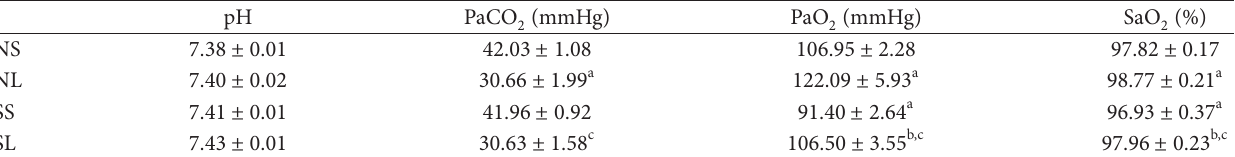
(d) F 5: Hematoxylin and eosin-stained sections of right upper lobe from different groups of rats taken aer 3 hours of LPS administration (HPF, 400x). (a) Normal rats injected with saline; (b) STZ-induced diabetic rats injected with saline; (c) normal rats injected with LPS; (d) STZ-induced diabetic rats injected with LPS. Arrows denote edematous changes of alveolar walls. T 1: Effects of LPS administration (15mg/kg, i.v.) on arterial blood gas in normal and diabetic